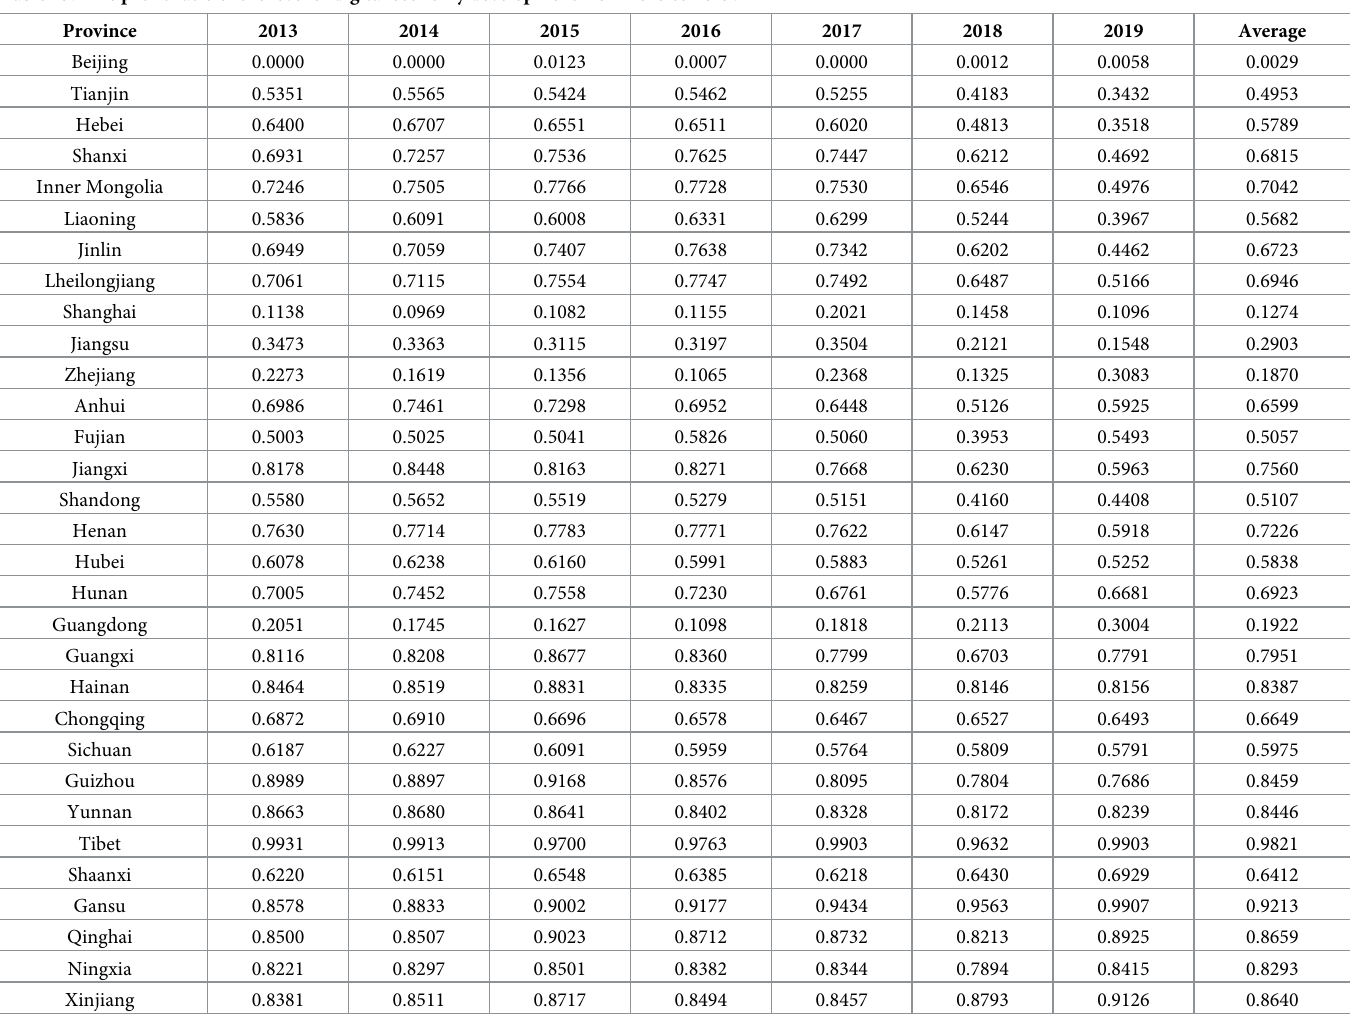
Table 13. The profit ratio of the level of digital economy development from 2013 to